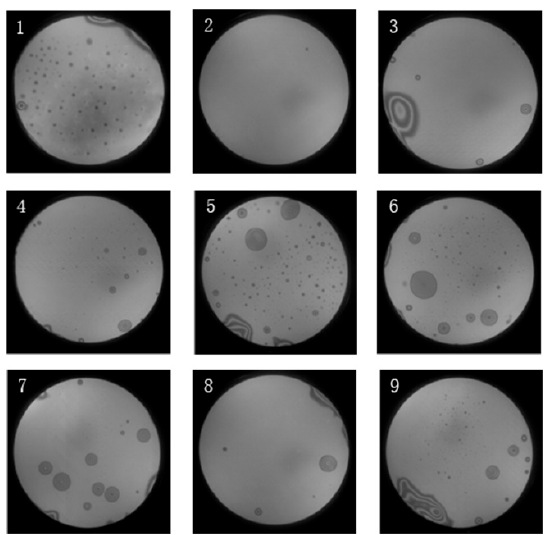
Figure 3. The nine infrared transmission images after annealing.